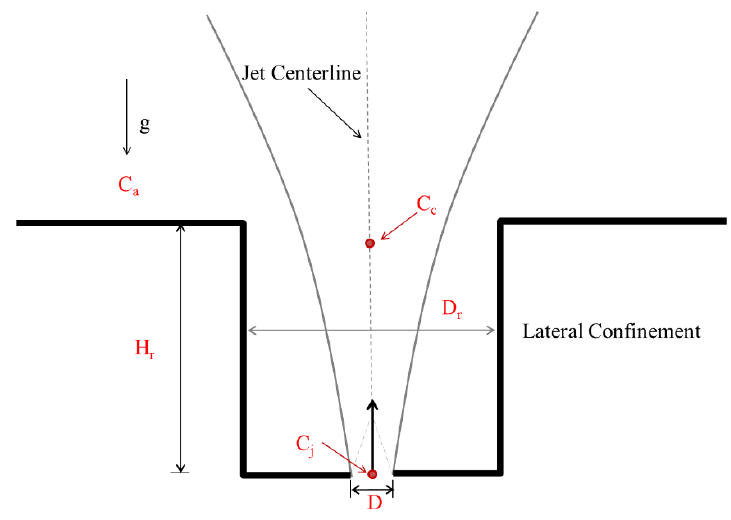
Figure 1. Sketch of a laterally confined vertical buoyant jet.